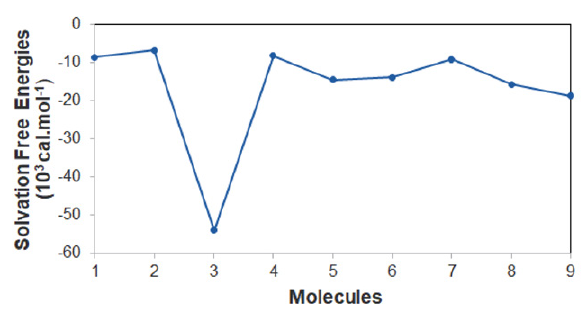
Figure 6. Solvation-free energies of